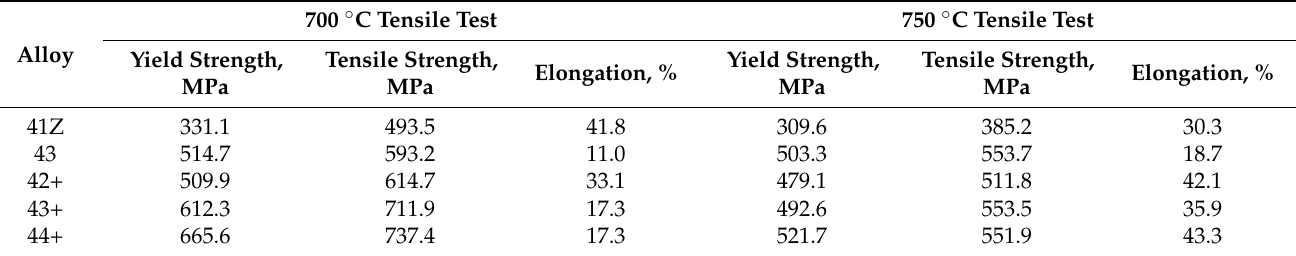
Table 3. Tensile test results of the model alloys in as-cast condition at 700 and 750 °C.